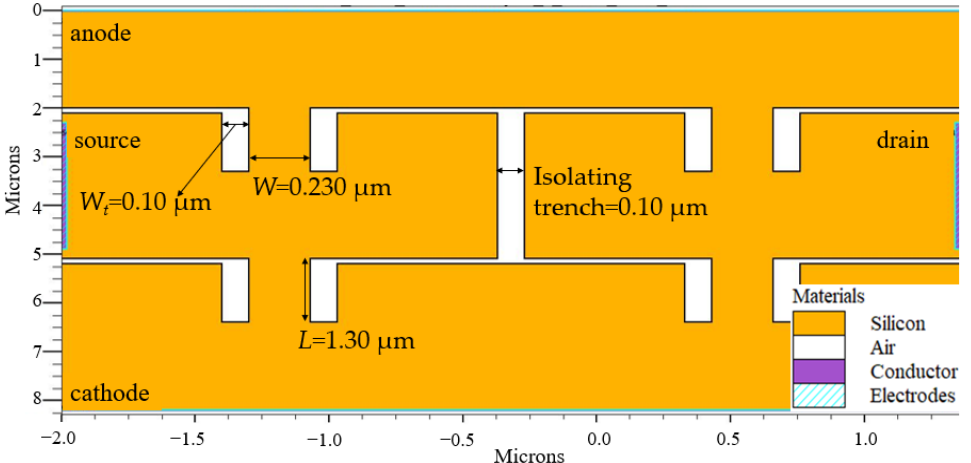
Figure 4. The structural parameters of the SSD full wave bridge rectifier.